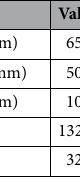
Table 2. Main geometric parameters of pump as turbine.